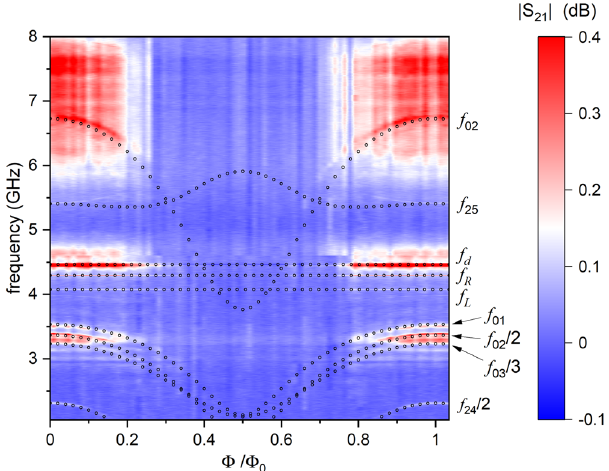
Fig. 4 Results of the two-tone spectroscopy with simulations to match the qubit transitions. Experimentally measured transmission coef fi cient ∣ S ∣ as a function of the normalized magnetic fl ux Φ / Φ 21 frequency f . Cross symbols indicate the modes of the resonators and the dotted lines are the theory predictions for the single and two photon interlevel